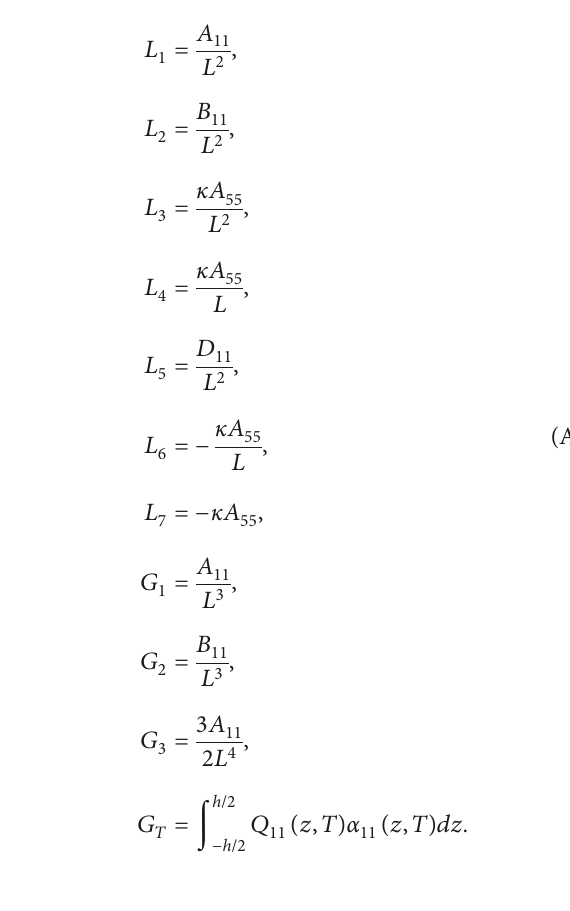
0 . 1m, L / H 25, K L 10 ,K NL (cid:29) (cid:29) (cid:29) (cid:29)